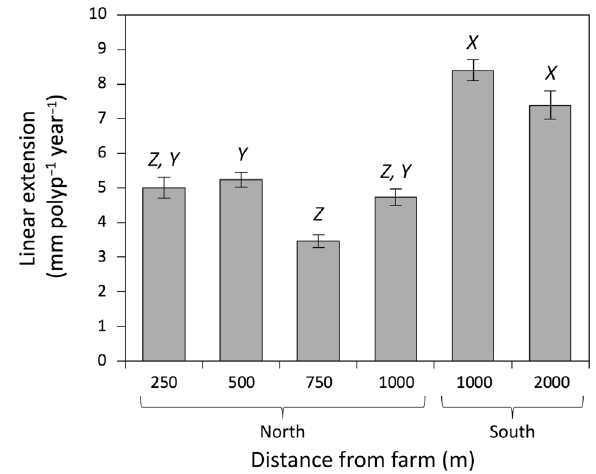
Fig. 3. Lipid content (mean ± SE) of Lophelia pertusa coral fragments after 1 yr of transplantation from Kjerringrevet (a nearby cold-water coral reef) to a gradient away from a salmon fish farm. n = 6 for all sites. Letters above the bars show statistically distinct groups as identified by Tukey’s HSD test (p <